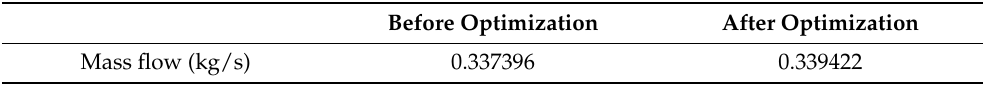
Table 3. Total air mass flow of guide channels before and after optimization. Before Optimization After